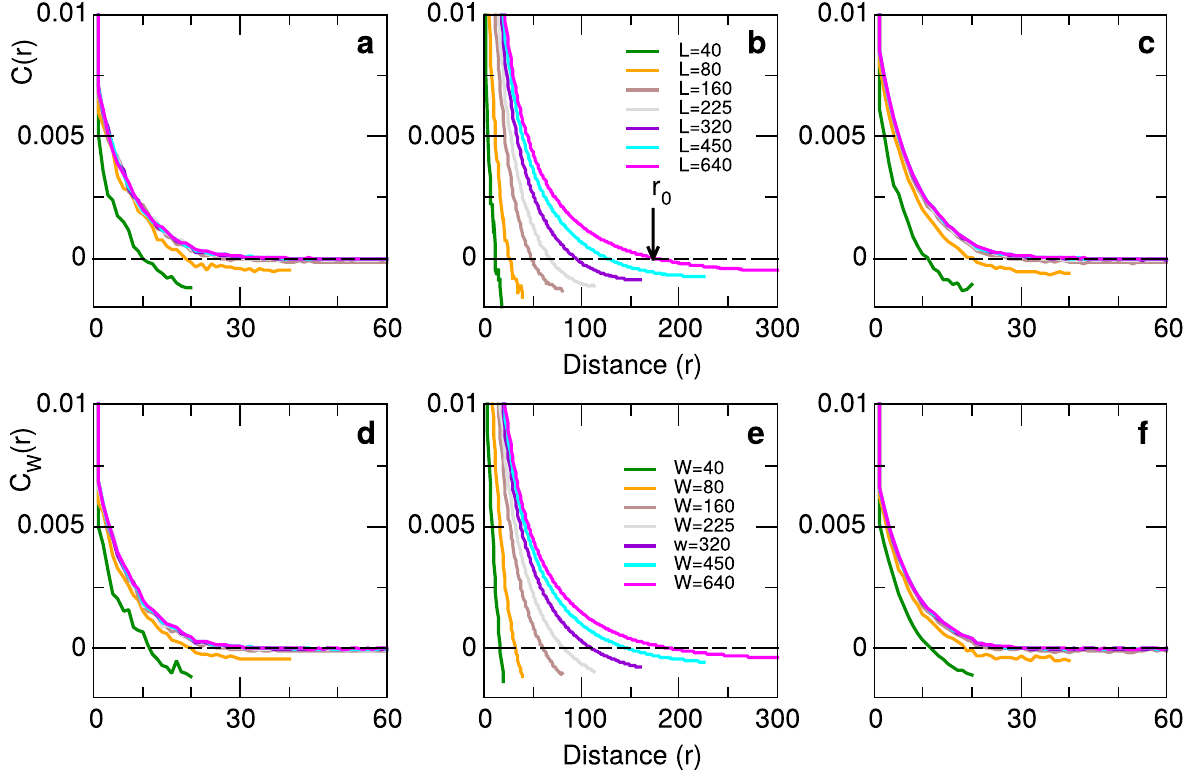
Figure 1. Connected correlation function of the neuronal network model. Curves in panels ( a – c ) for different system sizes L and those in ( d – f ) for different window sizes W computed on a system of size L = 1000 . Results are for three control parameter values corresponding to sub-critical ( σ = 0.64, panels a , d ), critical ( σ = 1.024, panels b , e ) and super-critical ( σ = 1.6 , panels c , f ) regimes of the model. Arrow in panel ( b ) illustrates the value of r 0 for L = 640